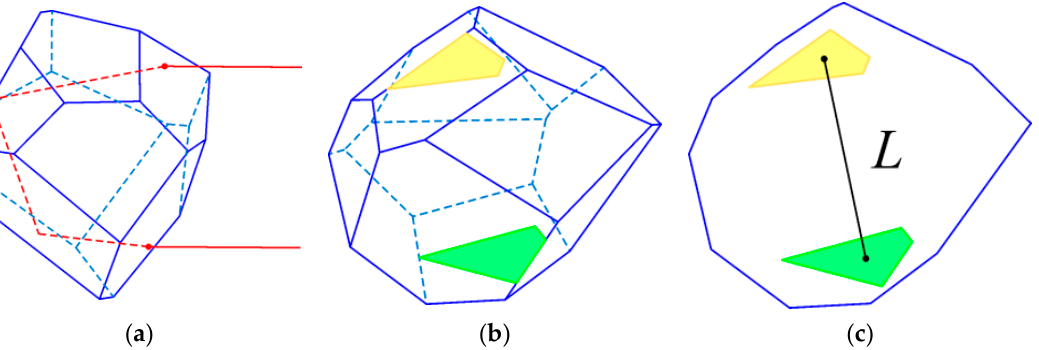
Figure 7. Conjugate pair of backscattering beams with grazing-incidence trajectories ( a ). Shapes of the beams on the exit facets ( b ) and on a plane perpendicular to the incident direction ( c ). The line L connects the centers of the beam projections.